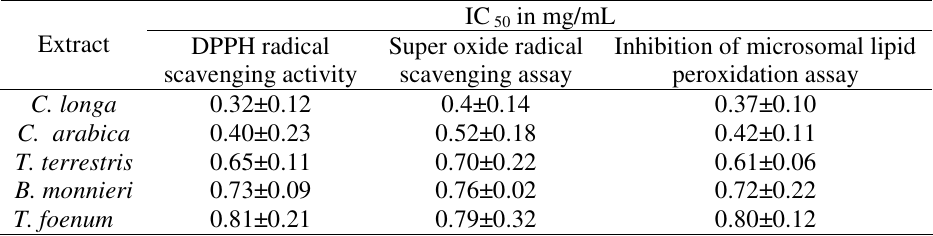
Table 1. IC values of the respective extracts in different in vitro models. Each values 50 represents SD± mean (n=3) Extract DPPH radical scavenging activity